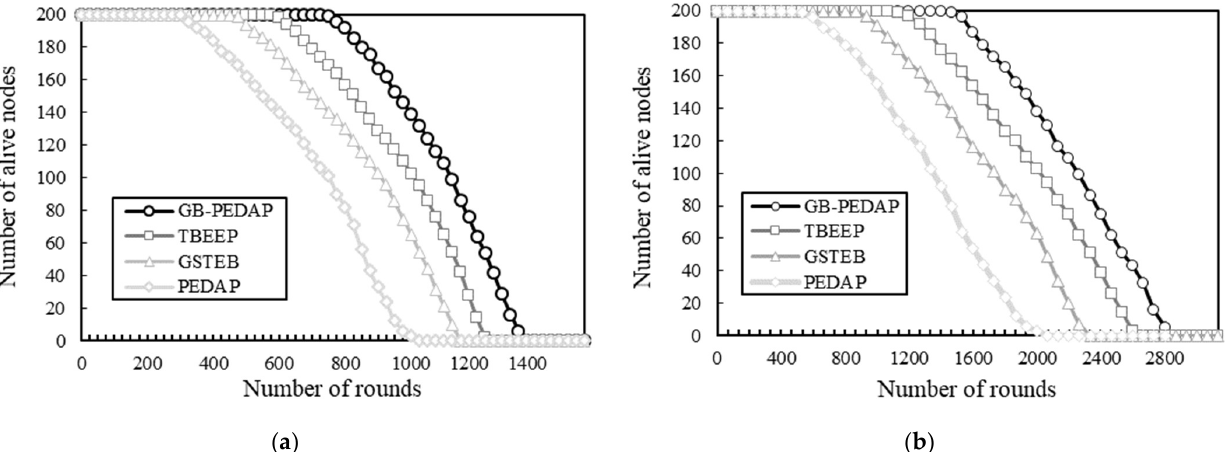
Figure 4. Number of alive nodes under different numbers of rounds: ( a ) initial energy is 0.25 J; ( b ) initial energy is 0.5 J.